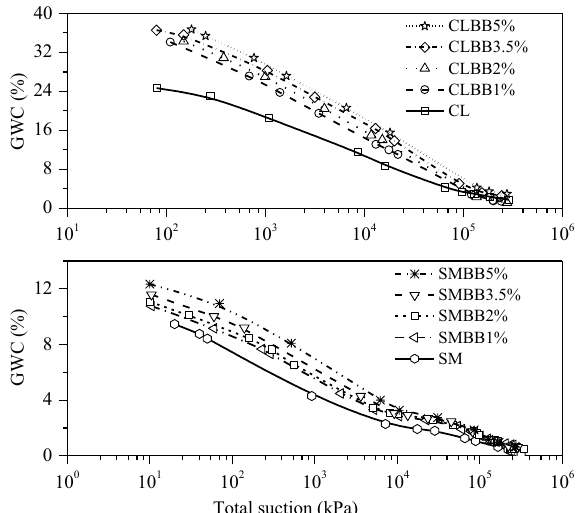
Figure 8. Gravimetric water content curves: for ( a ) CL, and ( b ) SM soil sample; each mixed with 0%, 1%, 2%, 3.5% and 5% (w/w) biochar content.